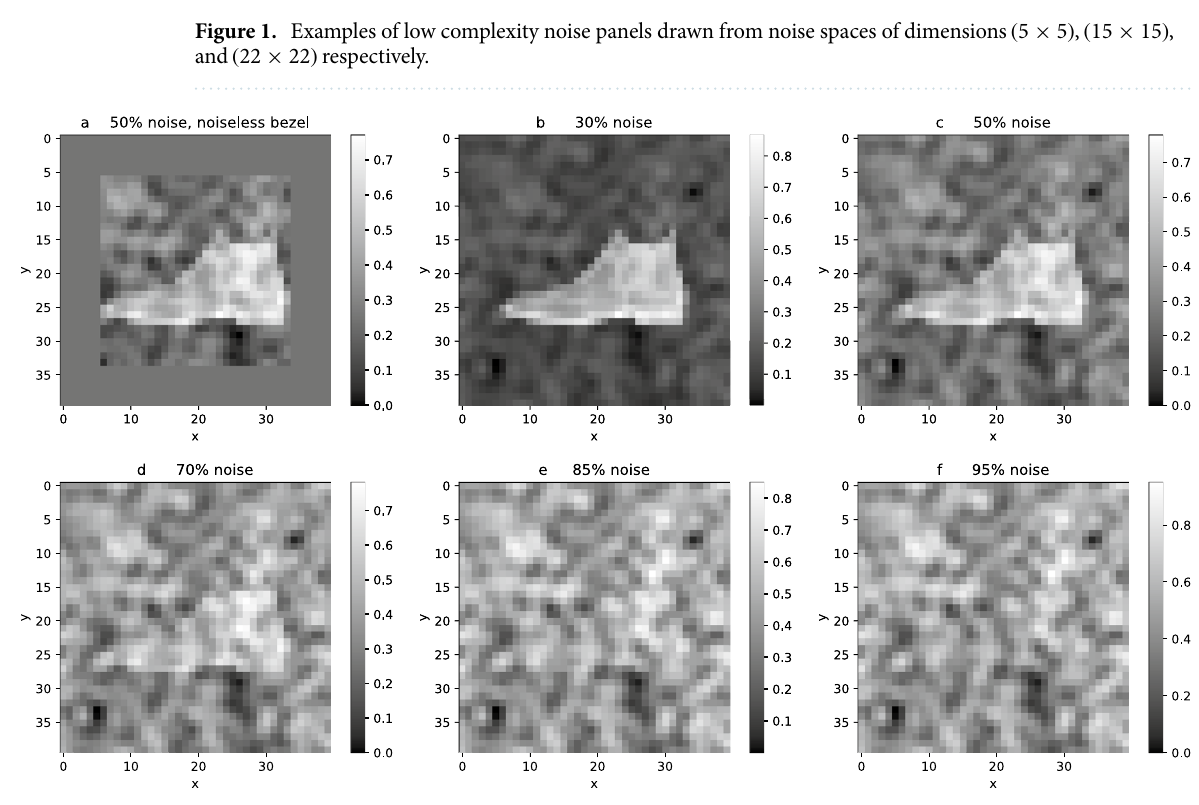
Figure 2. ( a ) Processed image from Fashion-MNIST dataset with added 6 pixel-width initially black bezel. All pixels are rescaled to an interval of [0.25, 0.75] (therefore the grey bezel has pixel values of 0.25). Finally, noise of amplitude interval [− 0.5, 0.5 ] is added to the 28 × 28 image. Panels ( b )–( f ) show examples where 30%, 50%, 70%, 85%, and 95% of the panel is noise,